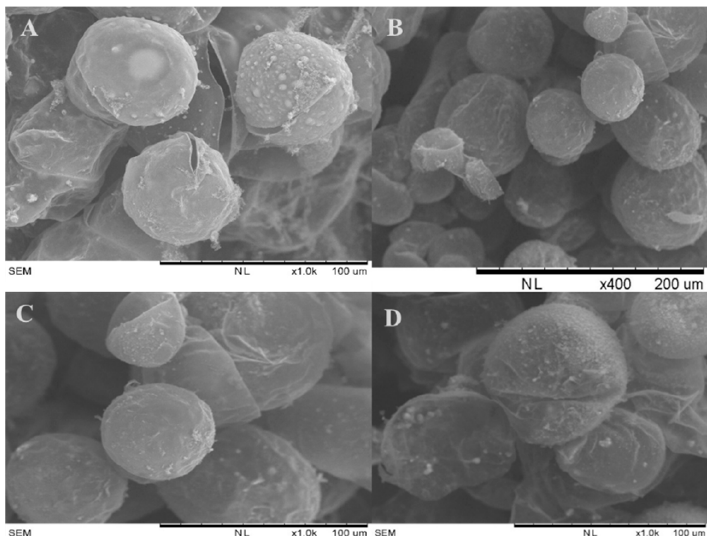
Figure 6. Scanning electron microscopic observation of callus culture of 4 varieties ( A ) MR220; ( B ) MR220-CL2; ( C ) MR232, and ( D ) Bario showing the globular and unfolded callus structure to differentiate the cells of the embryogenic callus from the 4 week culture. Bar ( A , C , D ) =100 µm, B = 200 µm.